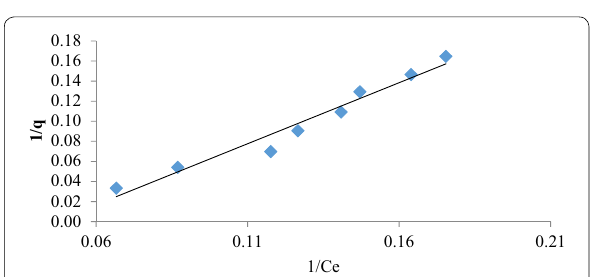
Fig. 2 Langmuir isotherm plot for fluoride removal using CAC